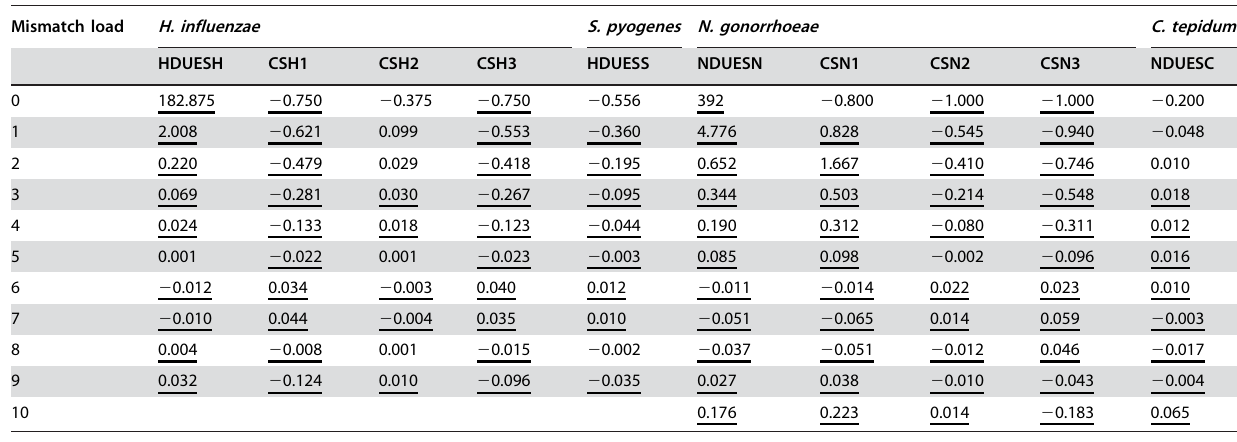
Sequence names as in Figure 1. Significant values, as by x 2 test, are underlined (see Table S1). doi:10.1371/journal.pone.0000741.t001 .